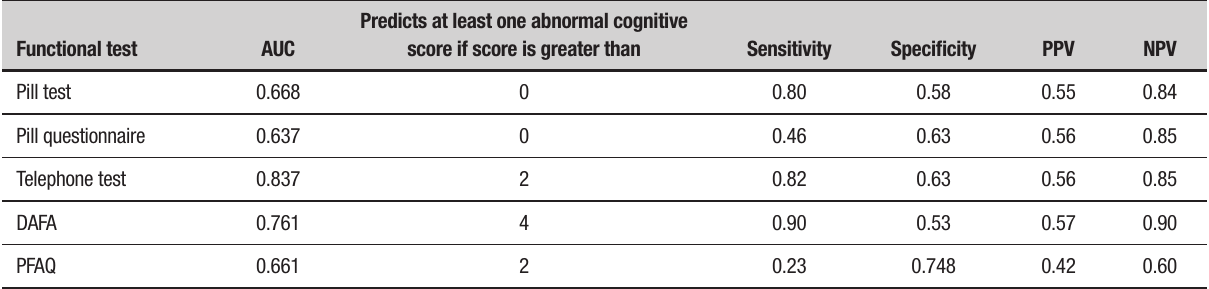
Table 3. Results of ROC curve analysis considering ability of functional tests to predict abnormal performance on a global cognitive test (MMSE and/or MDRS). Predicts at least one abnormal cognitive Functional test AUC score if score is greater than